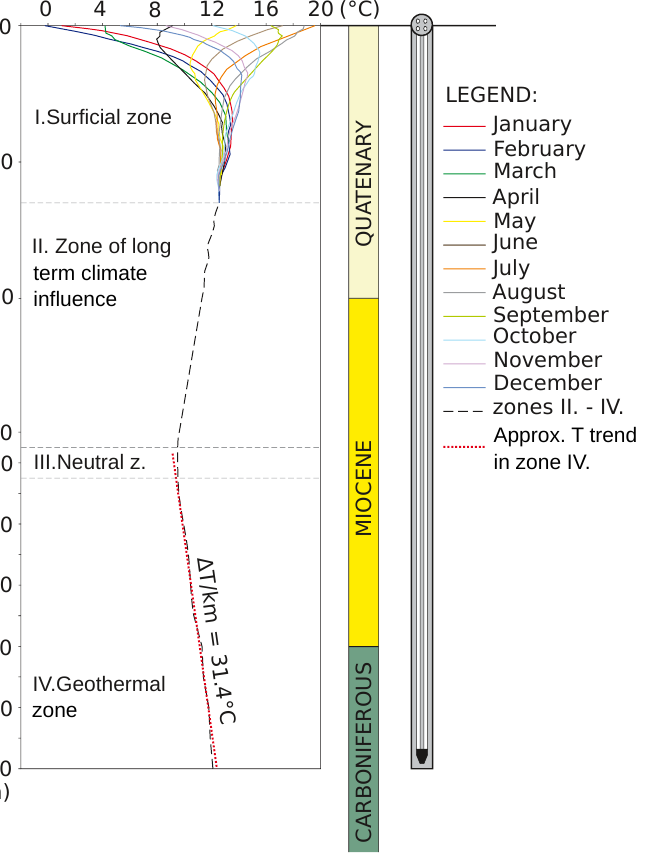
Figure 2. The structure of rock environment at Small Research Polygon according to the temperature influences of individual zones